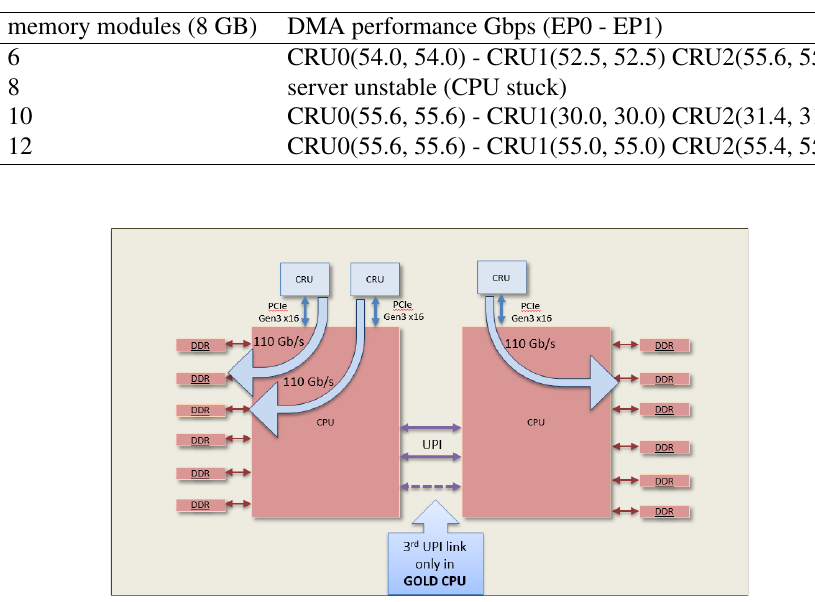
Figure 1. DMA data flow in a dual-socket system with three readout cards installed. The picture describes the data flow from the CRUs up to the memory of the server